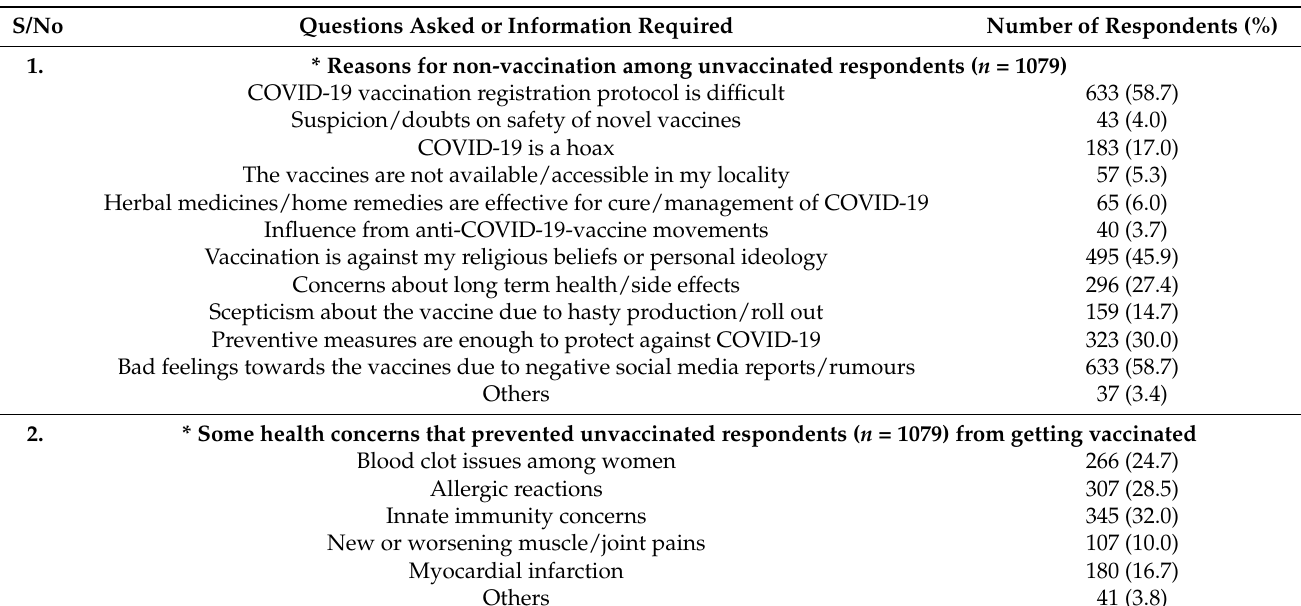
Table 2. Reasons for COVID-19 vaccine hesitancy and measures to improve the vaccine availability and acceptance in